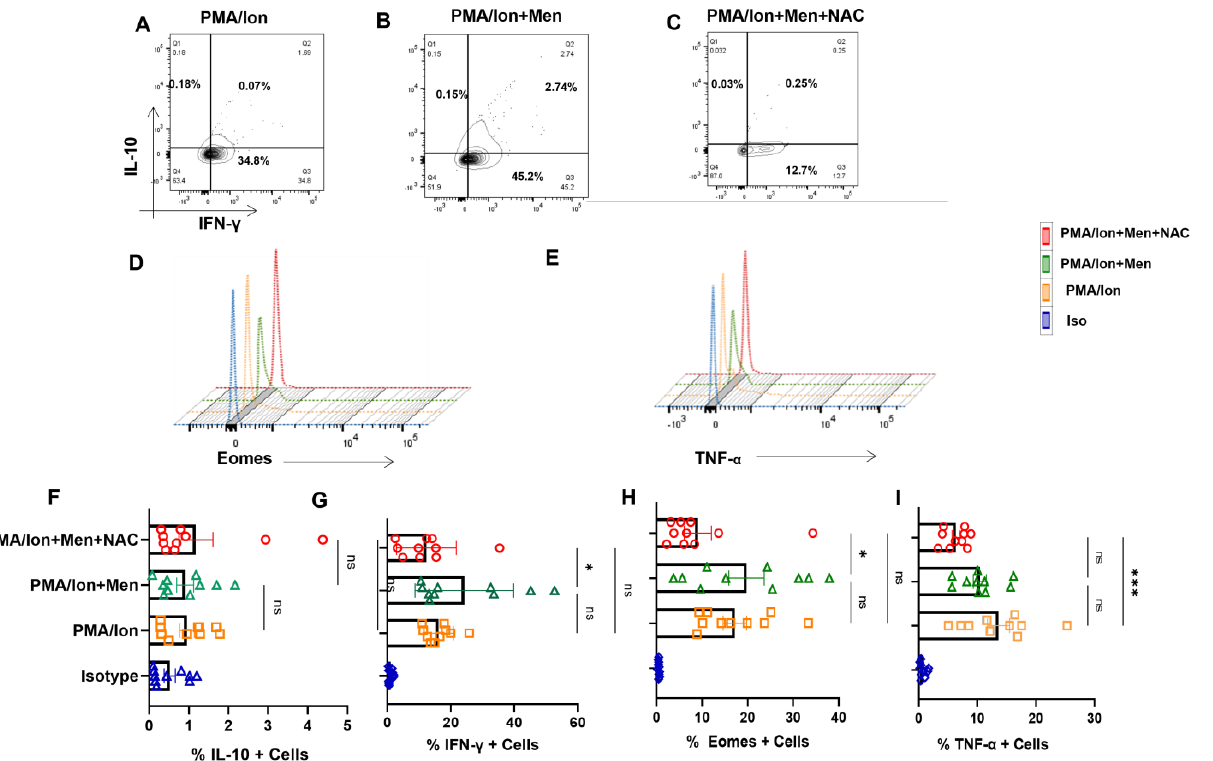
Figure 4. Redox modulation of inflammatory cytokines and transcription factor from SLE CD8 + T cells. CD8 + T cells were isolated from the PBMCs of SLE patients and treated with 2.5 μM menadione with or without NAC for 4 hrs and processed according to the protocol mentioned in the method section. Representative figures showing reduction in IFN −γ, TNF−α and Eomes following NAC ( 5 mM) treatment compared to their activation by PMA/Ion or treatment with menadione (2.5μM) ( A – E ). Cumulative graphical representation showing changes in IL − 10 and IFN −γ after menadione and NAC treatment ( F , G ). Cumulative graphical representation showing changes in Eomes and TNF −α after menadione and NAC treatment ( H , I ). Error bar indicates SEM. The experiments were done from 20 SLE patients ( n = 10) for cytokine assay and ( n = 10) for transcription factor assay, and all samples were tested for significance using one-way ANOVA, followed by Tukey’s multiple comparison. p < 0.05 was considered statistically significant (*); p < 0.001 was considered to highly significant (***); and ns means non-significant.